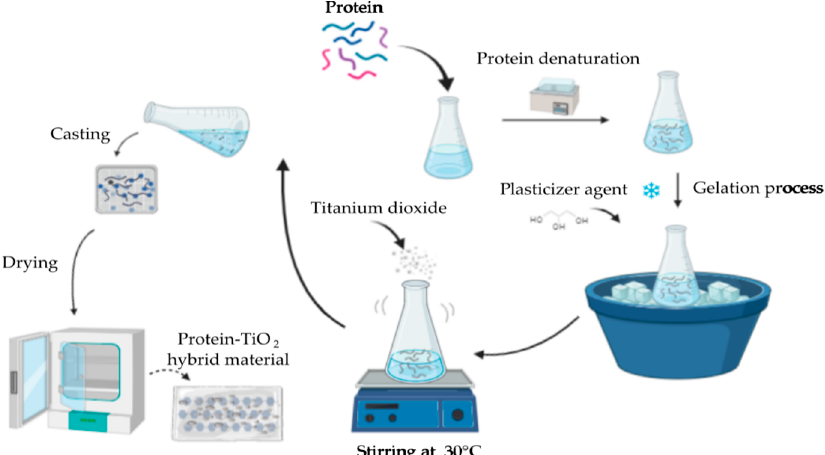
Figure 1. Schematic representation to laboratory scale of an evaporative casting method to prepare protein-based hybrid materials (adapted from Fan et al. [27], Al-Zoubi et al. [6]) (figure created with BioRender.com).